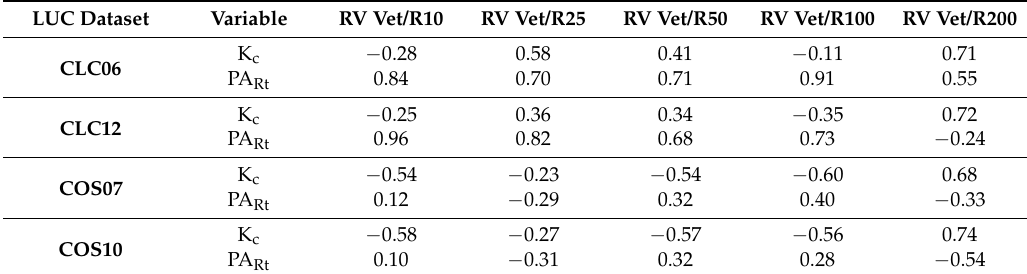
Table 7. Correlation coefficients between K c average, PA Rt , and relative variations (RV) area of the vector GI (Vet) verses different resolution (R) outputs (significance level p <